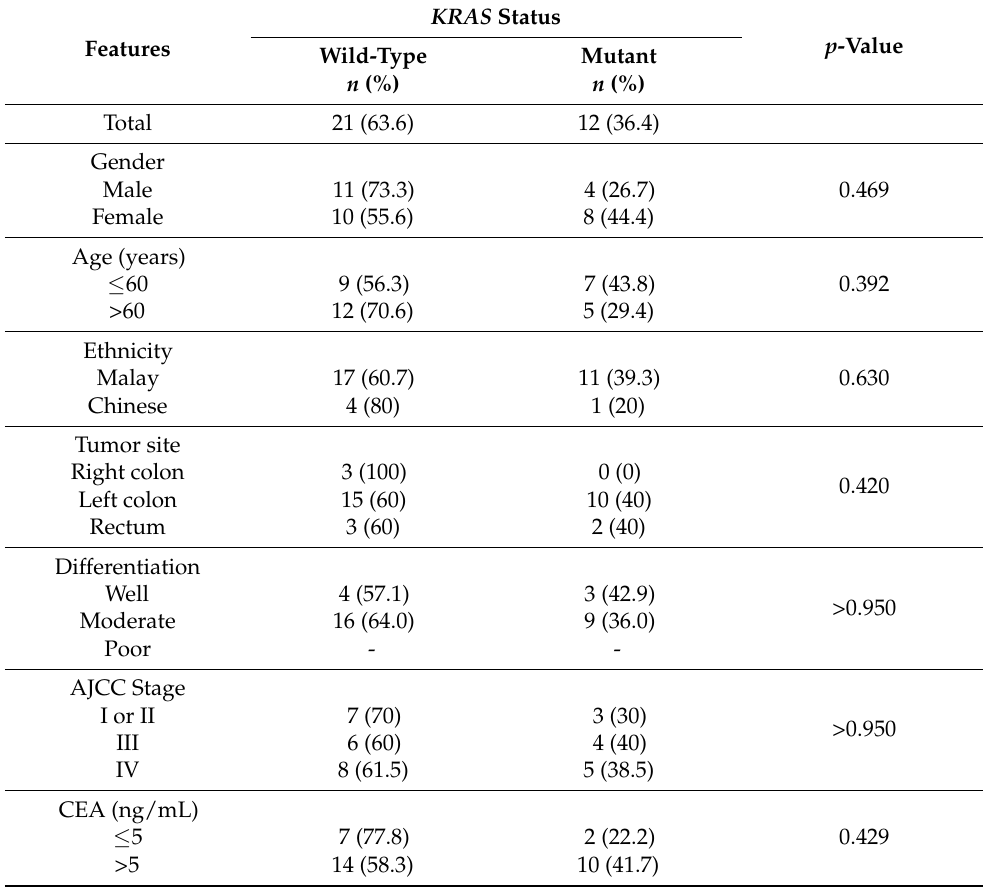
Table 1. Clinicopathological features of CRC patients according to KRAS mutational